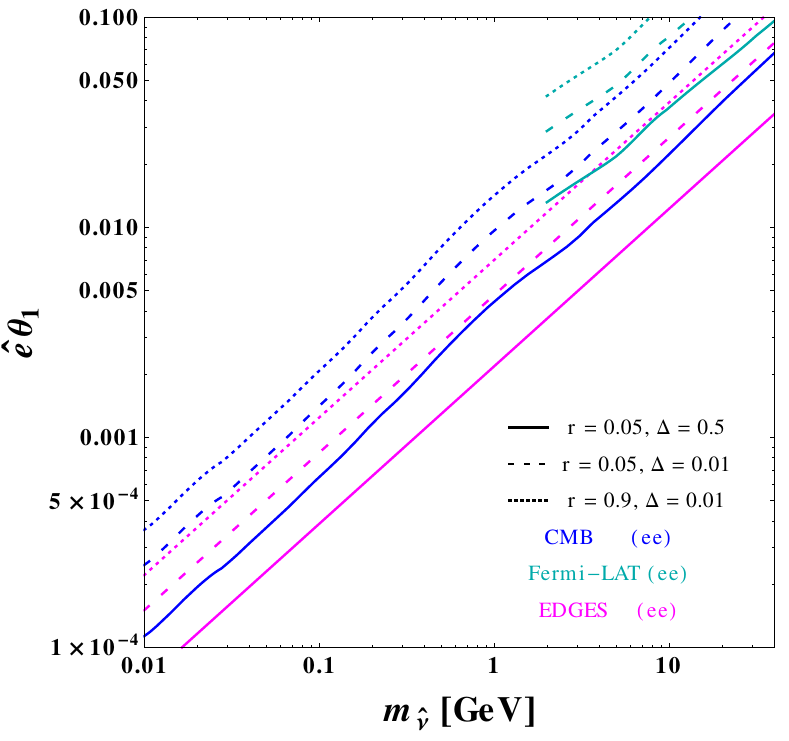
Figure 7 . The Fermi-LAT, CMB and EDGES bounds on DM annihilation rate in terms of ^ e(cid:18) 1 as a function of m ^ (cid:23) . The di(cid:11)erent color curves correspond to di(cid:11)erent experiments, with the one inferred from the EDGES to be the strongest assuming that no other e(cid:11)ect can enhance the 21cm line absorption. The solid curves represent the benchmark with r = 0 : 05 and (cid:1) = 0 : 5, where the constraints are strongest. The dashed and dotted curves are for di(cid:11)erent choices of r and (cid:1). All bounds are deduced from ee (cid:12)nal